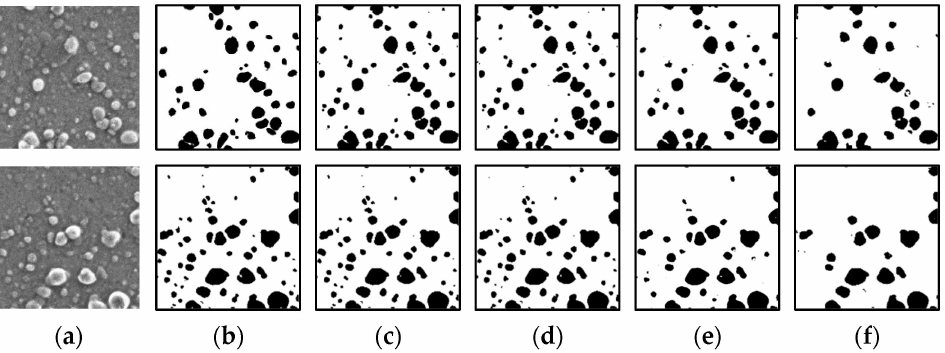
Figure 12. Results of image processing after segmentation (large number of particles). ( a ) Input data; ( b ) Output data (ground truth). Results obtained using ( c ) original ground truth data; and labeling data in which particles smaller than ( d ) 200 px; ( e ) 400 px; and ( f ) 600 px are removed.